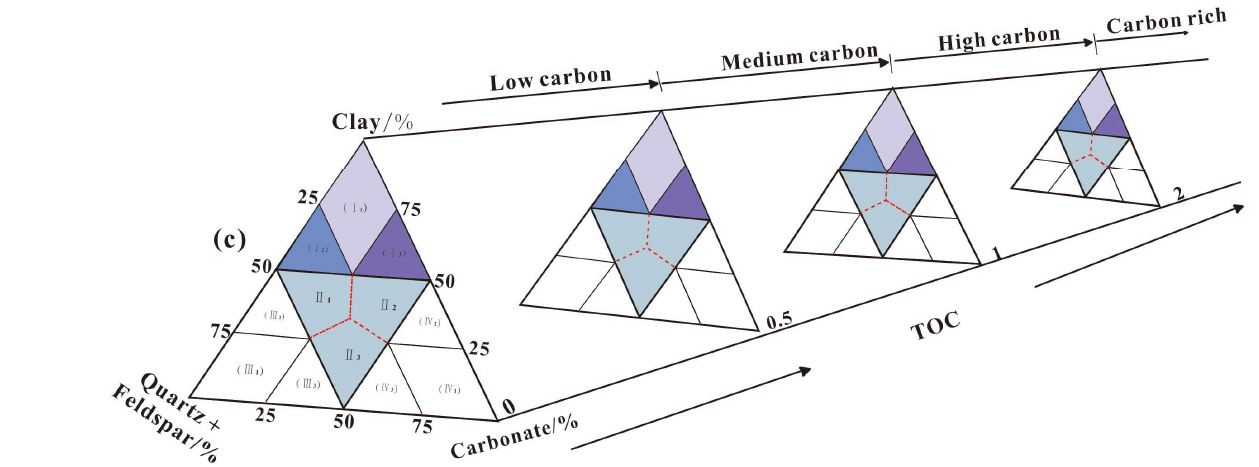
Figure 2. Lithofacies Division Scheme (revised from the method by Liu Zhongbao et al. [24] ).